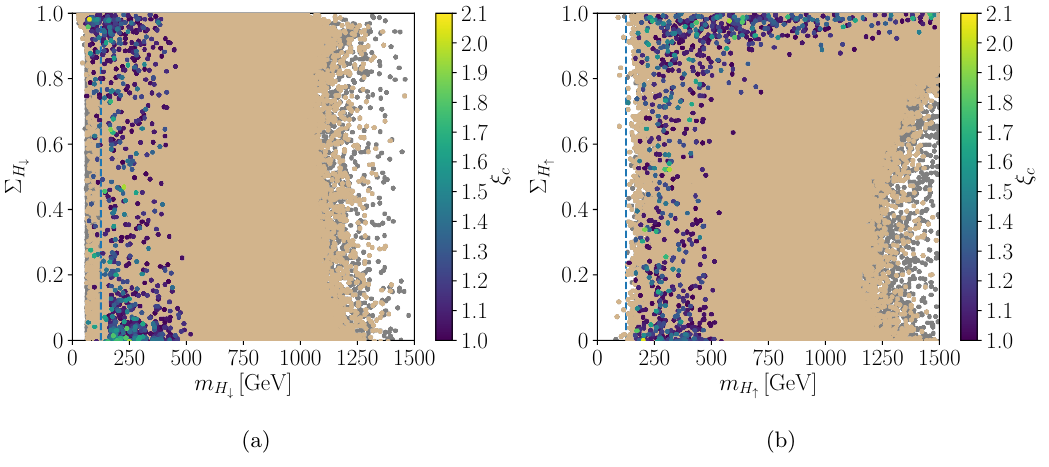
Figure 3 . N2HDM T1: the singlet admixture (cid:6) versus the mass for H # (left) and H " (right). The grey points are all parameter points passing the experimental and theoretical checks of ScannerS